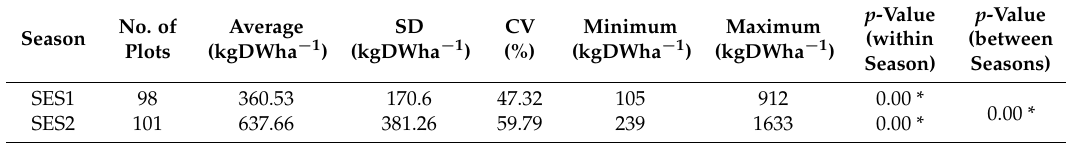
Table 3. Standard deviation, mean, CV, and p -values for pearl millet yield (kgDWha − 1 ). No. of Average SD CV Season Plots (kgDWha − 1 ) (kgDWha − 1 )